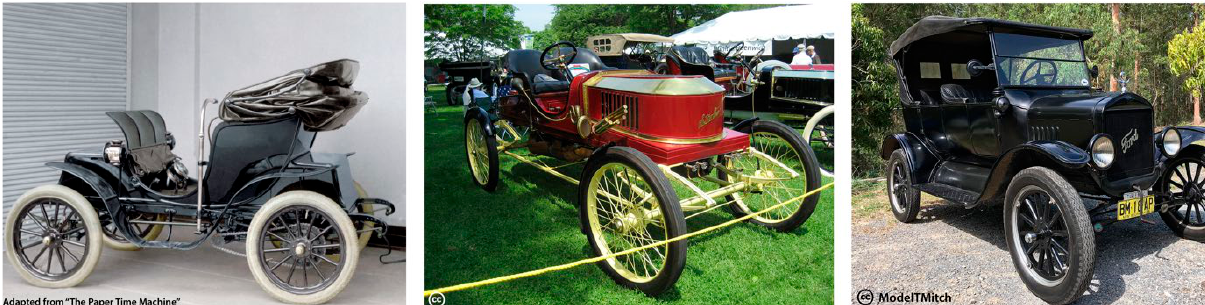
Figure 1. From left to right, examples of electric, steam and internal combustion engine cars of the early 20th century (1906, 1908, 1925,